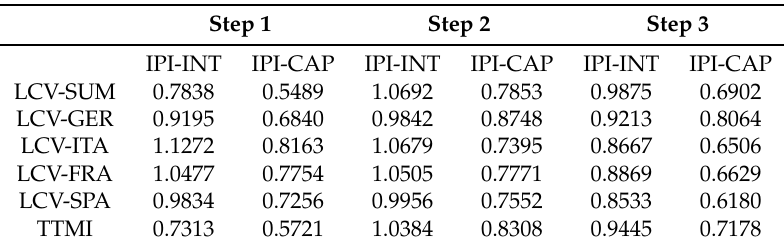
Table A24. Comparison of root mean squared error with expanding window applied to conditional var with three variables. The forecast windows expands itself from 2015:01 to 2018:12. The ratio between RMSEs is shown. A value less than one shows an improvement over benchmark.